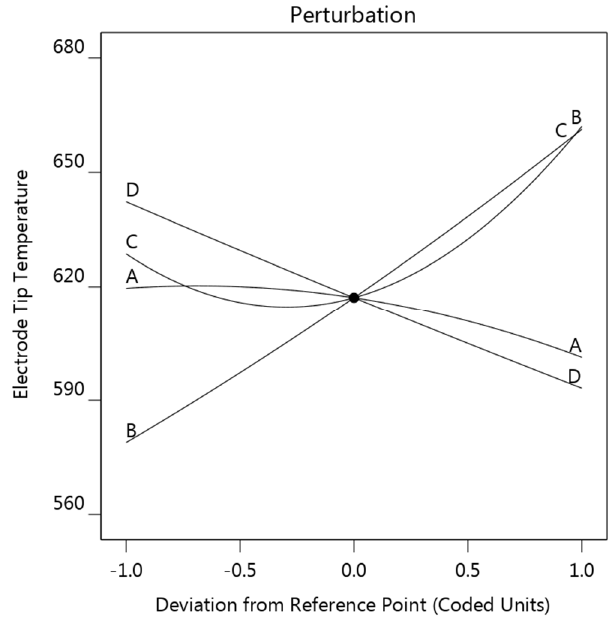
Figure 8. Perturbation plot showing the effect of the four factors on the electrode tip temperature (strip thickness ( A ), welding current ( B ), strip resistivity ( C ), and sheet thickness ( D